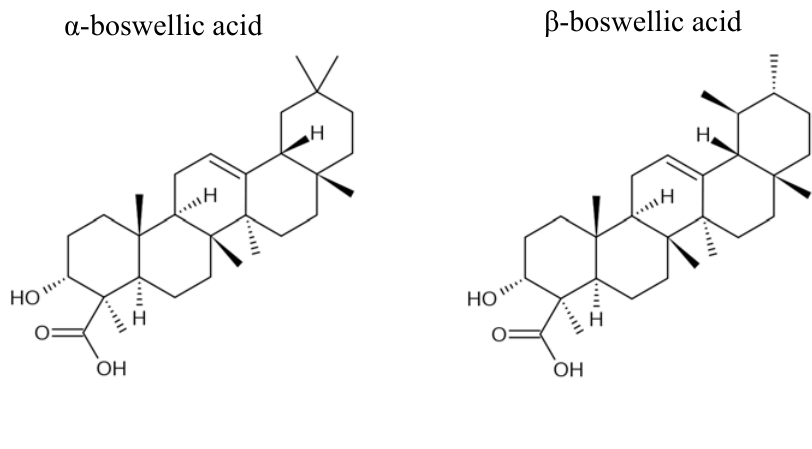
Figure 1. Chemical structures of α - and β -boswellic acid (http://en.wikipedia.org/wiki/